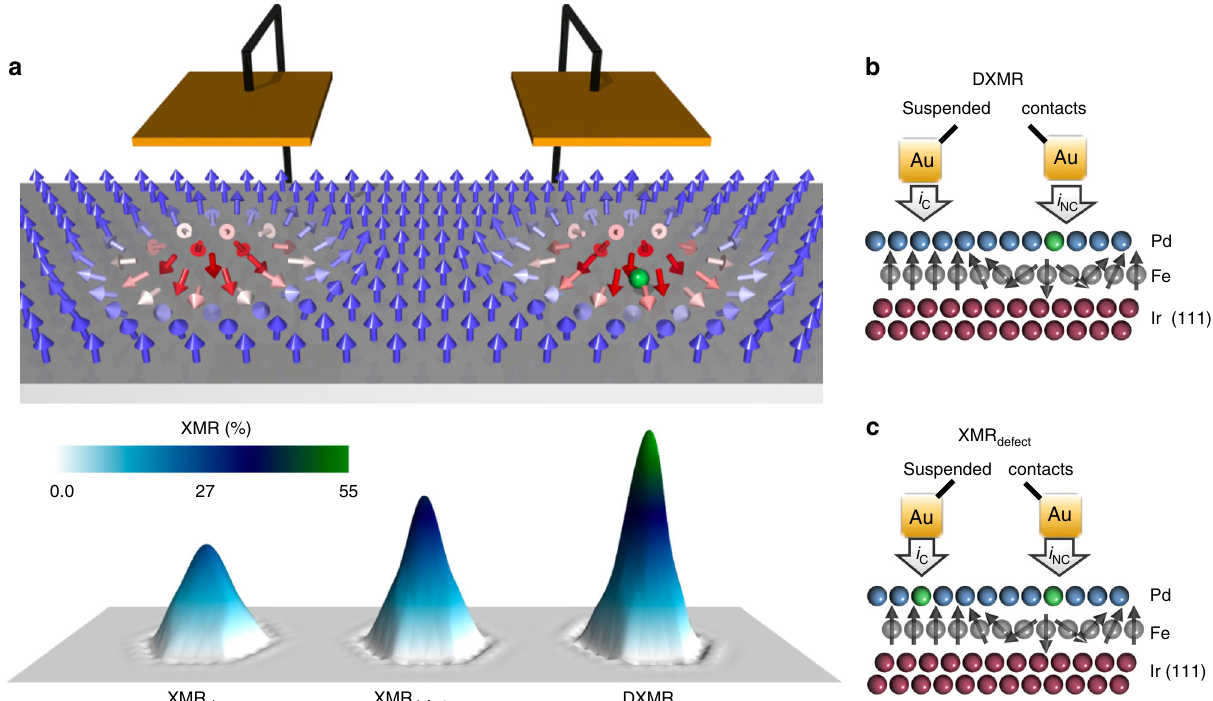
Fig. 1 All-electrical detection of magnetic skyrmions in the presence of defects. a Illustration of a tunneling transport experiment to read magnetic skymions on fcc-PdFe bilayer on the Ir(111) surface away from (left) or at the vicinity of (right) a single-atomic defect indicated by a green sphere. The spin- mixing of the electronic structure within the non-collinear environment leads to changes on the tunneling conductance allowing the magnetic data information to be sensed in a current perpendicular-to-plane geometry. The various XMRs signals, for the clean system and in the presence of defects, are shown on the lower panel. Depending on the reference background two types of XMR signals can be measured, b while the clean ferromagnetic substrate leads to the defect-enhanced XMR (DXMR), c the substrate-defect complex background leads to the XMR defect